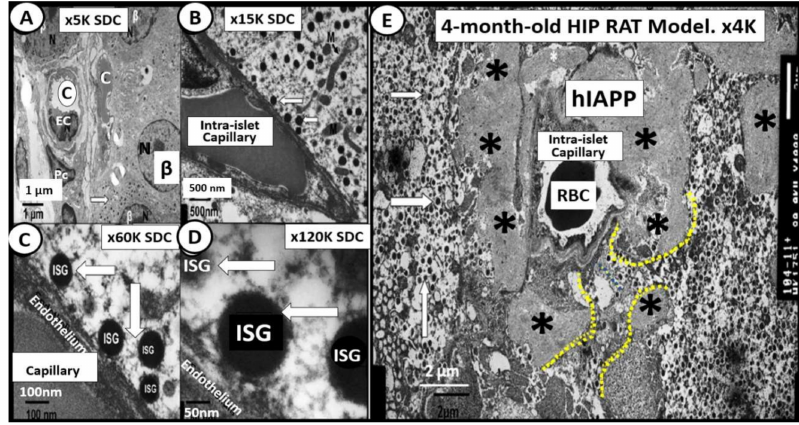
Figure 9. Normal insulin secretory granule docking in control and impaired docking to the capillary endothelium in the HIP rat models. Panels ( A – D ) illustrate the close association of β -cells to the islet capillaries, which allow for proper docking of the insulin secretory granule (ISG) (white open arrows) for absorption of insulin in the 4-month-old control Sprague–Dawley control (SDC). Magnifications and scale bars are in each image. Panel ( E ) depicts the di ff use islet amyloid deposition (asterisks) in the 4-month-old HIP rat model. This image allows one to note the impairment of ISG docking with the islet capillary. Note only the small spaces (outlined by yellow dashed lines) that are able to allow for minimal docking of ISGs. Note how the ISGs come to the peri-capillary islet amyloid and appear to be abruptly quarantined without access to the islet capillaries. These findings would fall into stages II and III of Figure 4 in Section 1. Magnification × 4000; scale bar = 2 µ m. Asterisks = islet amyloid; C = capillary; hIAPP = human islet amyloid polypeptide; ISG = insulin secretory granule; K = 1000; M = mitochondria; RBC = red blood